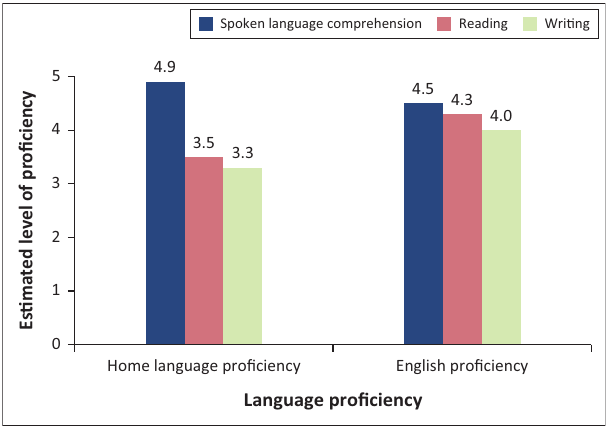
FIGURE 1: Home language versus English proficiency in spoken language comprehension, reading and writing for participants from non-English